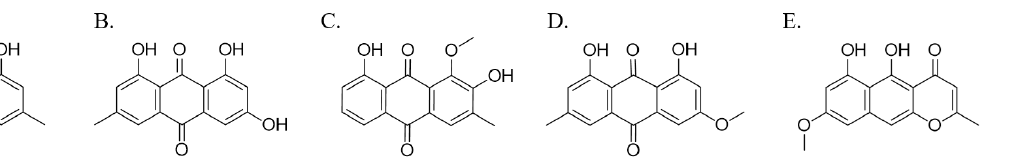
Figure 1. Chemical structures of four anthraquinones and one naphthopyrone from Cassiae semen: chrysophanol ( A ), emodin ( B ), obtusifolin ( C ), physcion ( D ), and rubrofusarin ( E ).